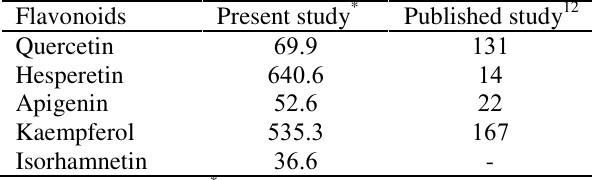
Table 4. The comparison of